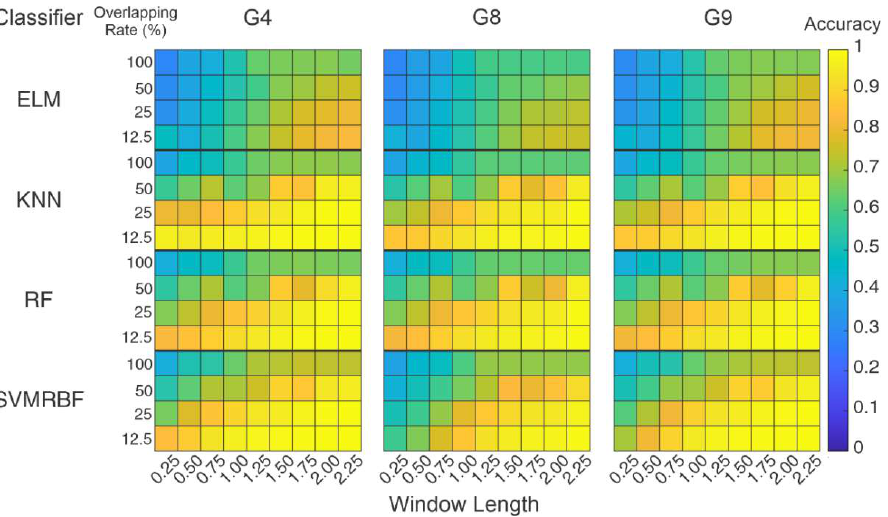
Figure 8: Results for the segmentation analysis. The color bar indicates the accuracy for each classifier on the influence of feature sets and segmentation parameters. The high accuracies are concentrated for large window length and small overlap